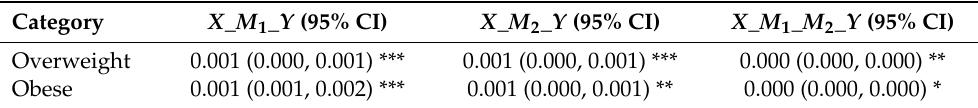
Table 5. The separate mediating effect of GDM, high mTG levels and their combination on the relationship of overweight/obesity with the risk of